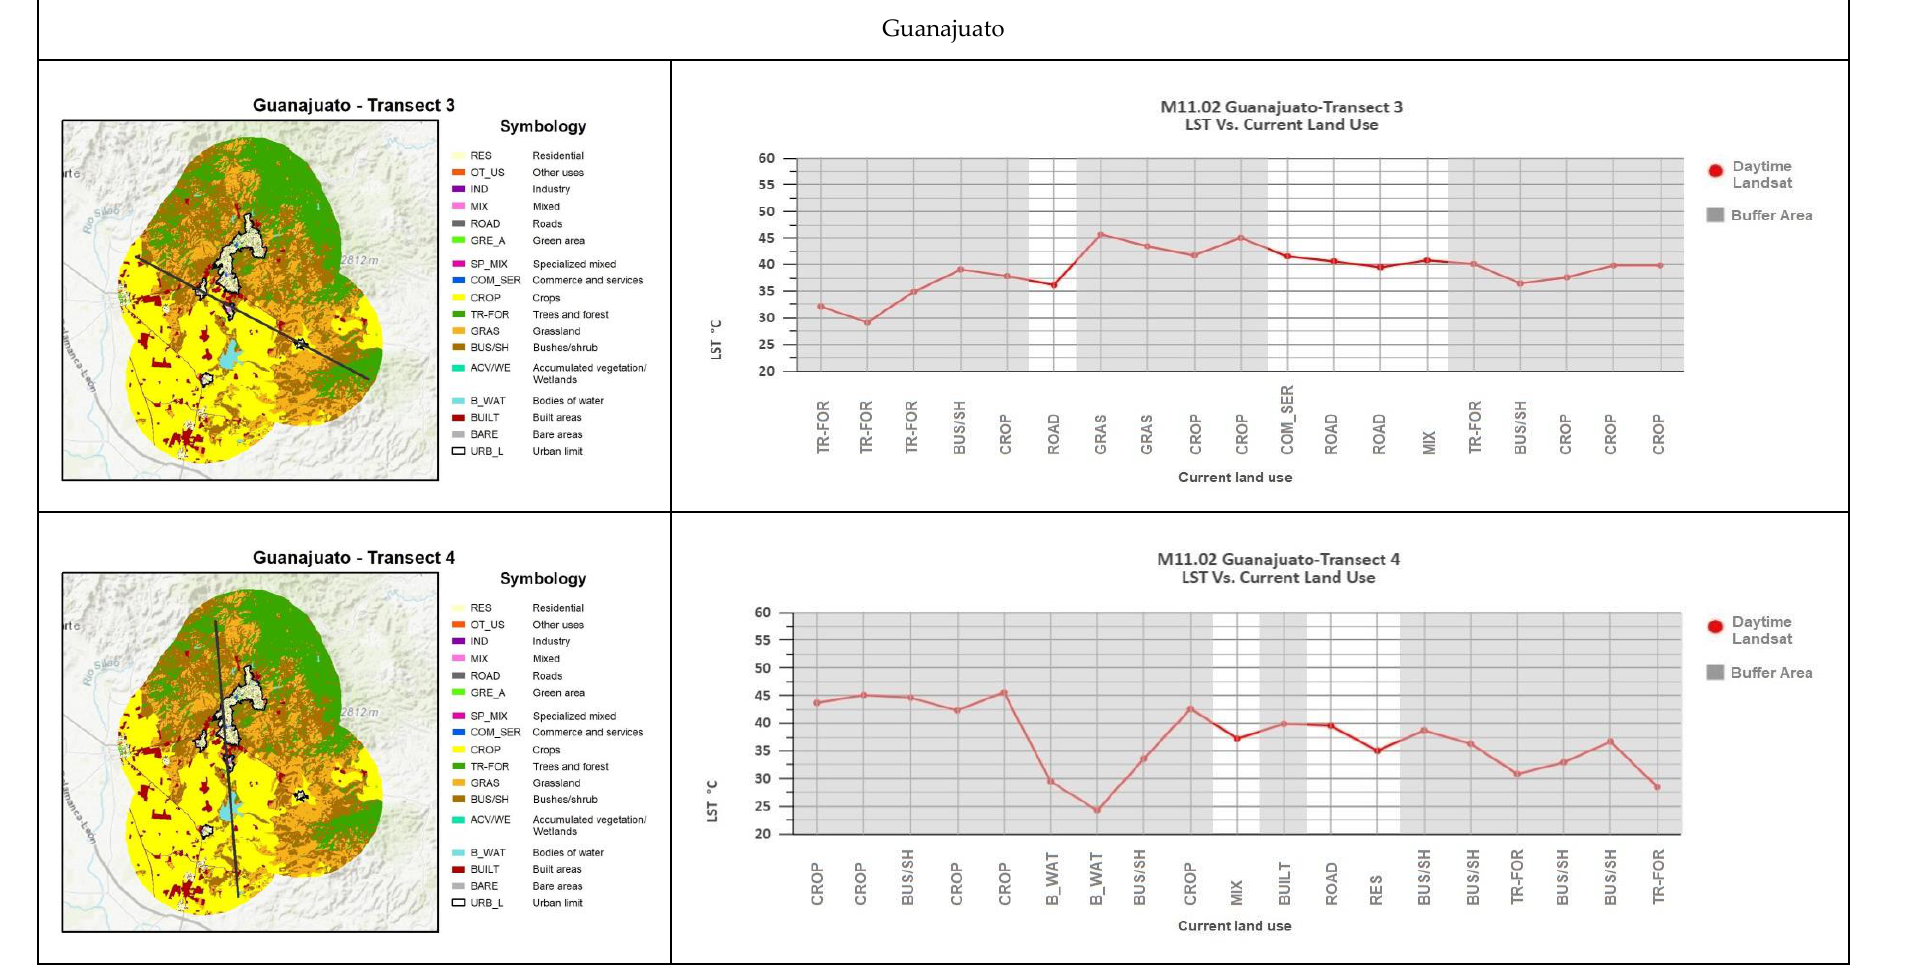
Figure A3. Transects of the Ten Metropolitan Cities and Four Conurbations, with the SUN code.